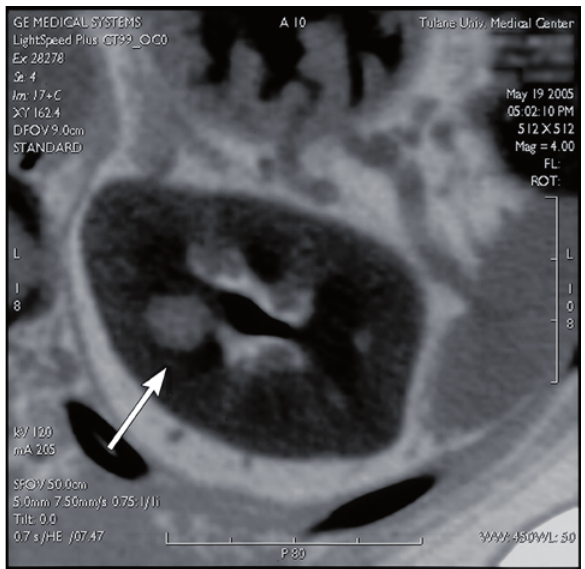
Figure 3 - gas dissecting into the